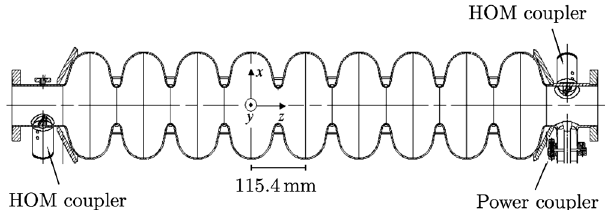
FIG. 2. Longitudinal cross section of a TESLA